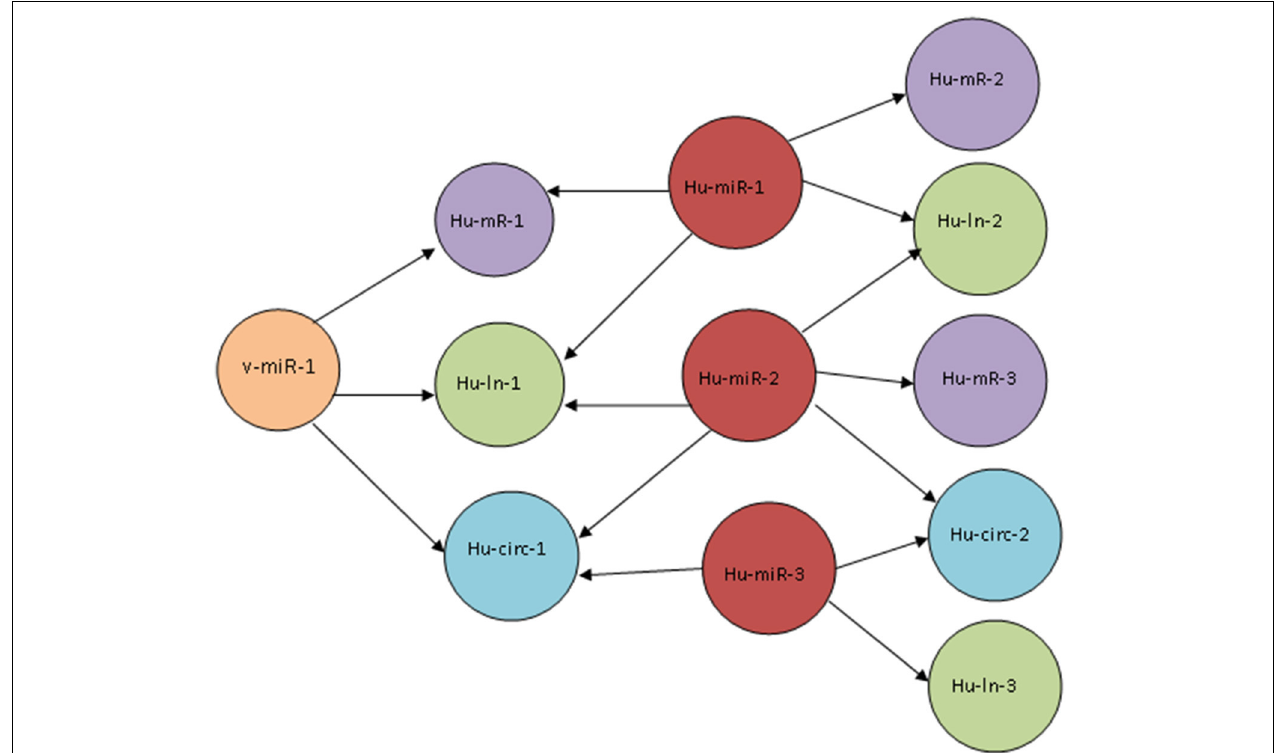
FIGURE 2 | Schematic diagram of the connections in a host-virus ceRNA network. A viral miRNA (v-miR-1) targets three cellular transcripts (Hu-mR-1, Hu-ln-1, and Hu-circ-1). These transcripts are also targeted by host miRNAs Hu-miR-1, Hu-miR-2, and Hu-miR-3. The cellular